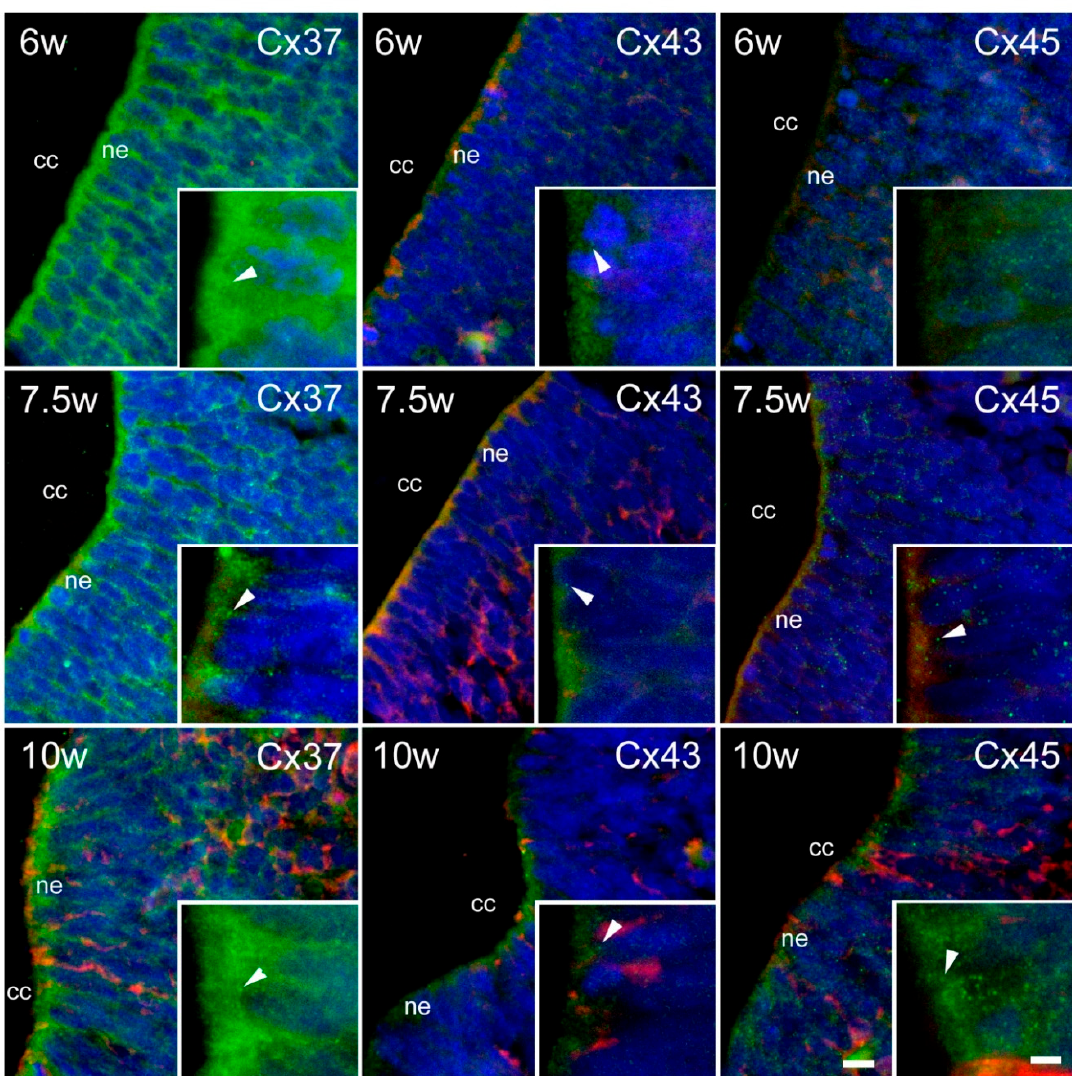
Figure 3. Expression of Cxs 37, 43, and 45 in the inner layer (INL) of the SC in human conceptuses. Thoracic segments of the SC of 6, 7.5, and 10 week-old human conceptuses were stained for Cx37, Cx43, and Cx45 (green), and protein gene peptide (PGP) 9.5 (red). The INL was presented on photomicrographs, with neuroepithelium (ne)—a layer in contact with the central canal (cc)—details shown in insets. Objective magnification—40× (scale bar = 20 µm); insets—100× (scale bar = 8 µm). Arrowheads are pointing to the granular pattern of Cx immunoreactivity in the cytoplasm of neuroepithelial cells.